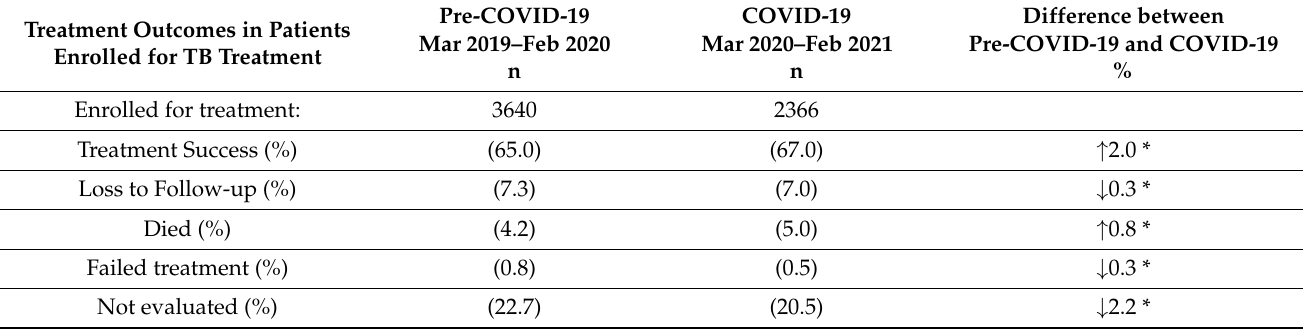
Table 2. Treatment outcomes in TB patients enrolled for treatment in 18 health facilities in Nairobi, Kenya, during pre- COVID-19 and COVID-19 periods.